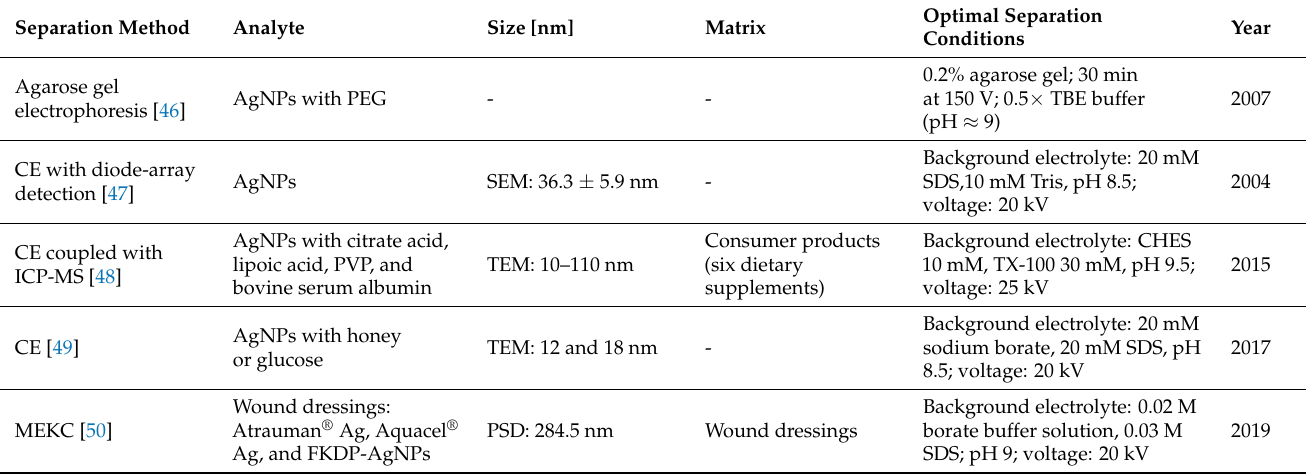
Table 5. Overview of the AgNPs separation by